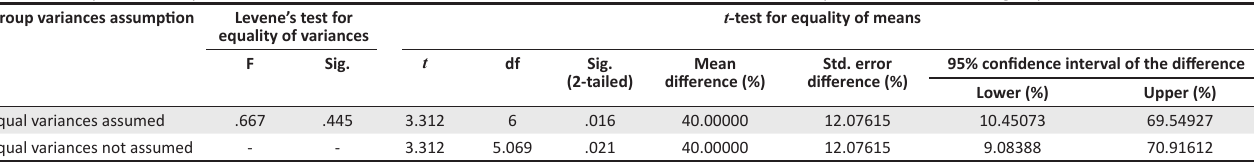
TABLE 5: Independent samples t -test on the difference in scores for each learner in Phase Two between the experimental and control groups. Group variances